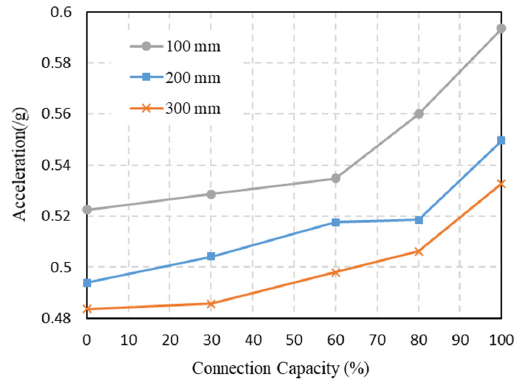
Figure 24. Peak acceleration of 10-story frames.